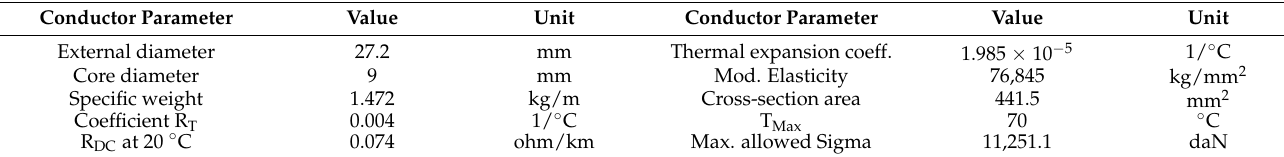
Table 1. Technical parameters of the ACO-400 conductor installed on the demo